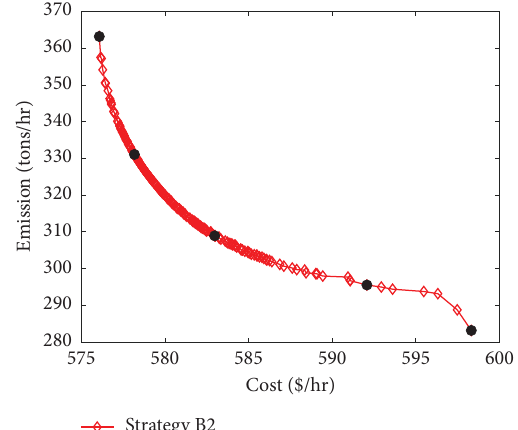
Figure 8: Pareto-optimal front for strategy B